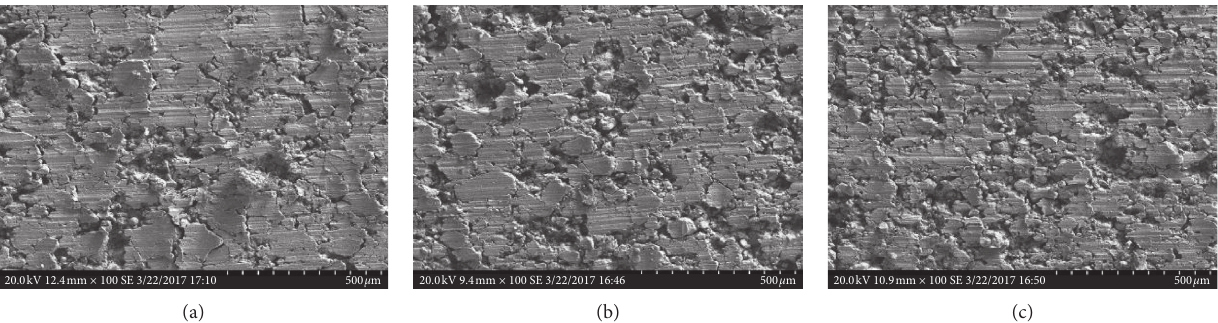
Figure 8: Machined surface morphologies machined at rake angles of (a) − 20 ° , (b) − 5 ° , and (c) 15 °